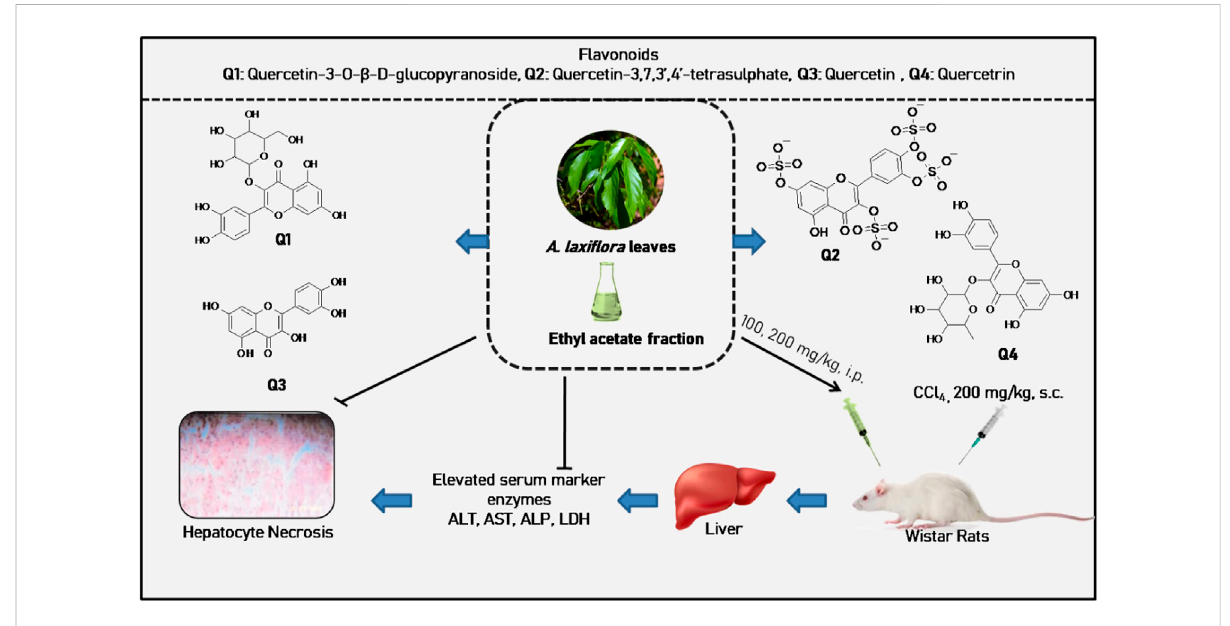
FIGURE 6 Hepatoprotective activity of A. laxi fl ora derived from Oloyede et al.